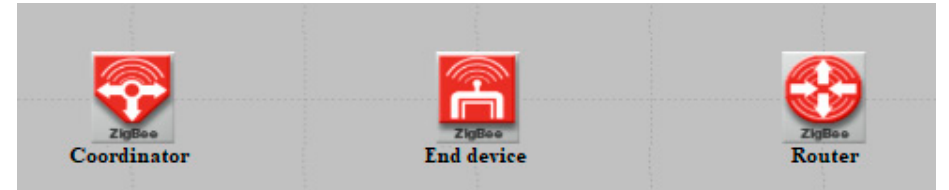
Figure 3. ZigBee device symbols in the Riverbed Modeler simulator.